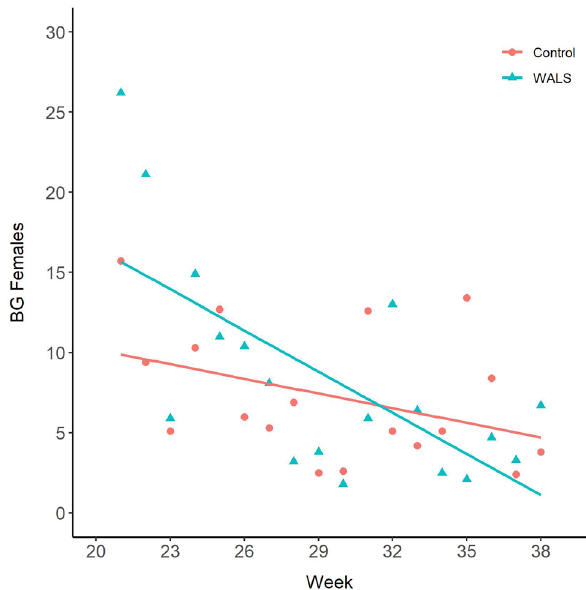
Fig. 8 Average females caught in BGS traps for each week for untreated control and WALS sites